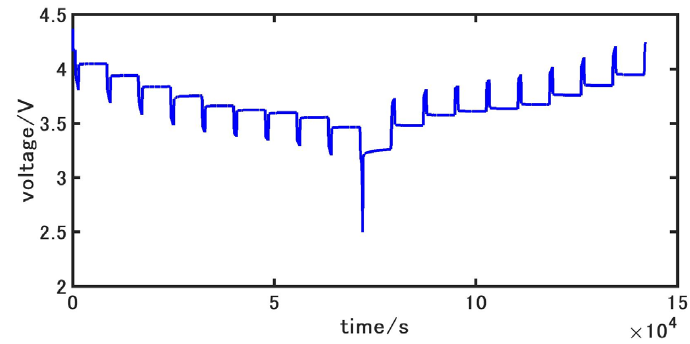
Figure 2. Current of Incremental Current Condition.